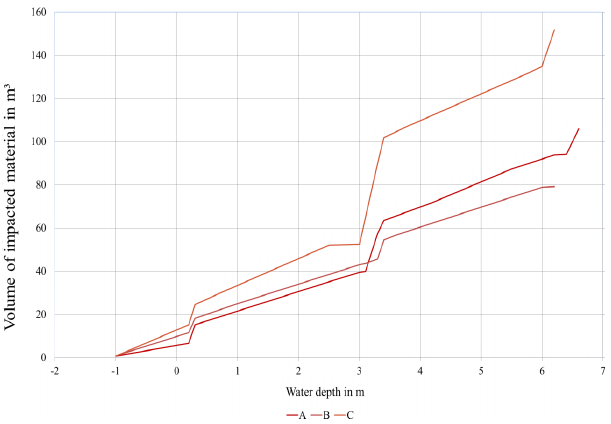
Figure 6. Median and standard deviation of the depth–physical im- pact functions for the three taxonomic-code buildings “2221123” in depth-physical impact functions for the Magangué, taxonomic code ‘ 2221123’ in Magangué , Colombia